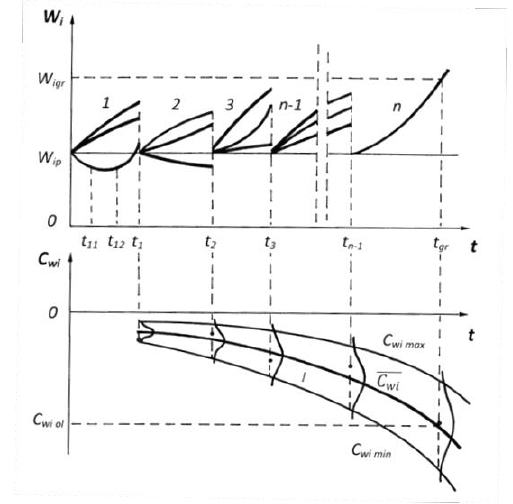
Fig. 4. Graphic interpretation of changes in the index of change intensity of oil properties for the population of objects: W p – preliminary index